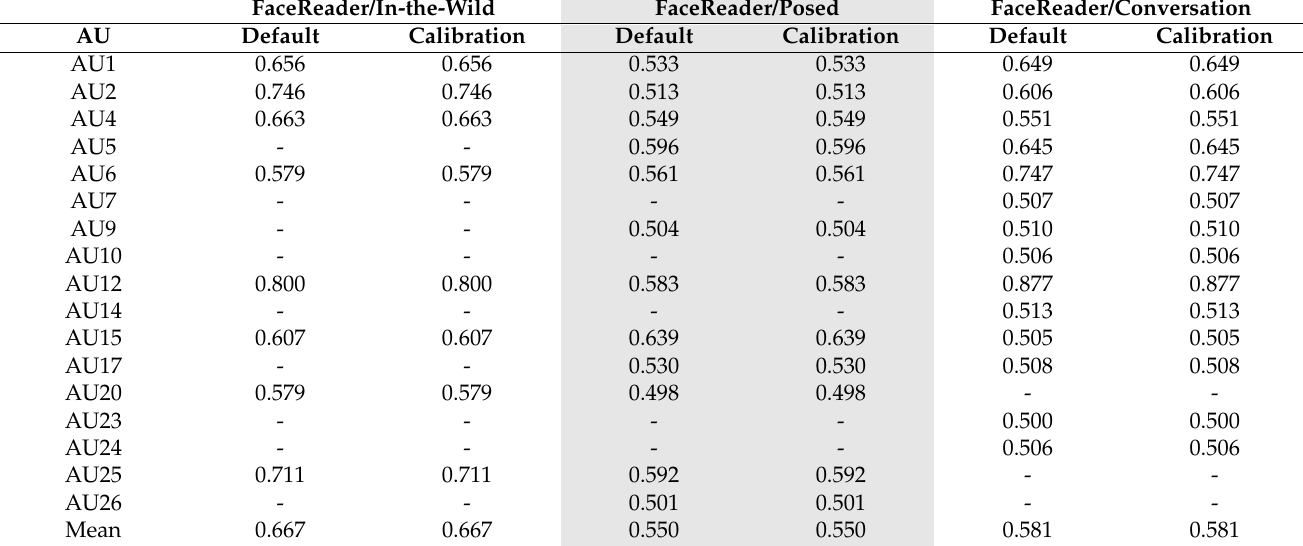
Table 4. Average AUC scores for each AU in FaceReader: Default indicates that there was no